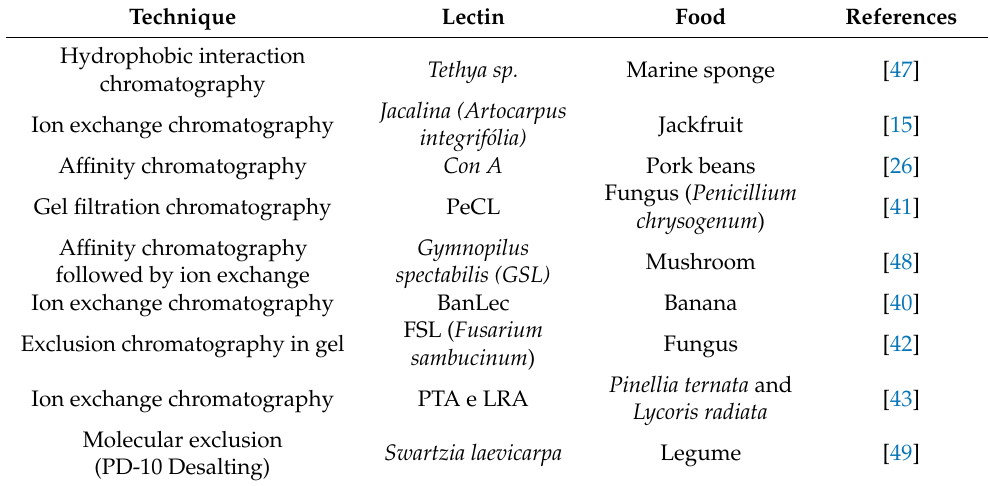
Table 2. Lectin purification